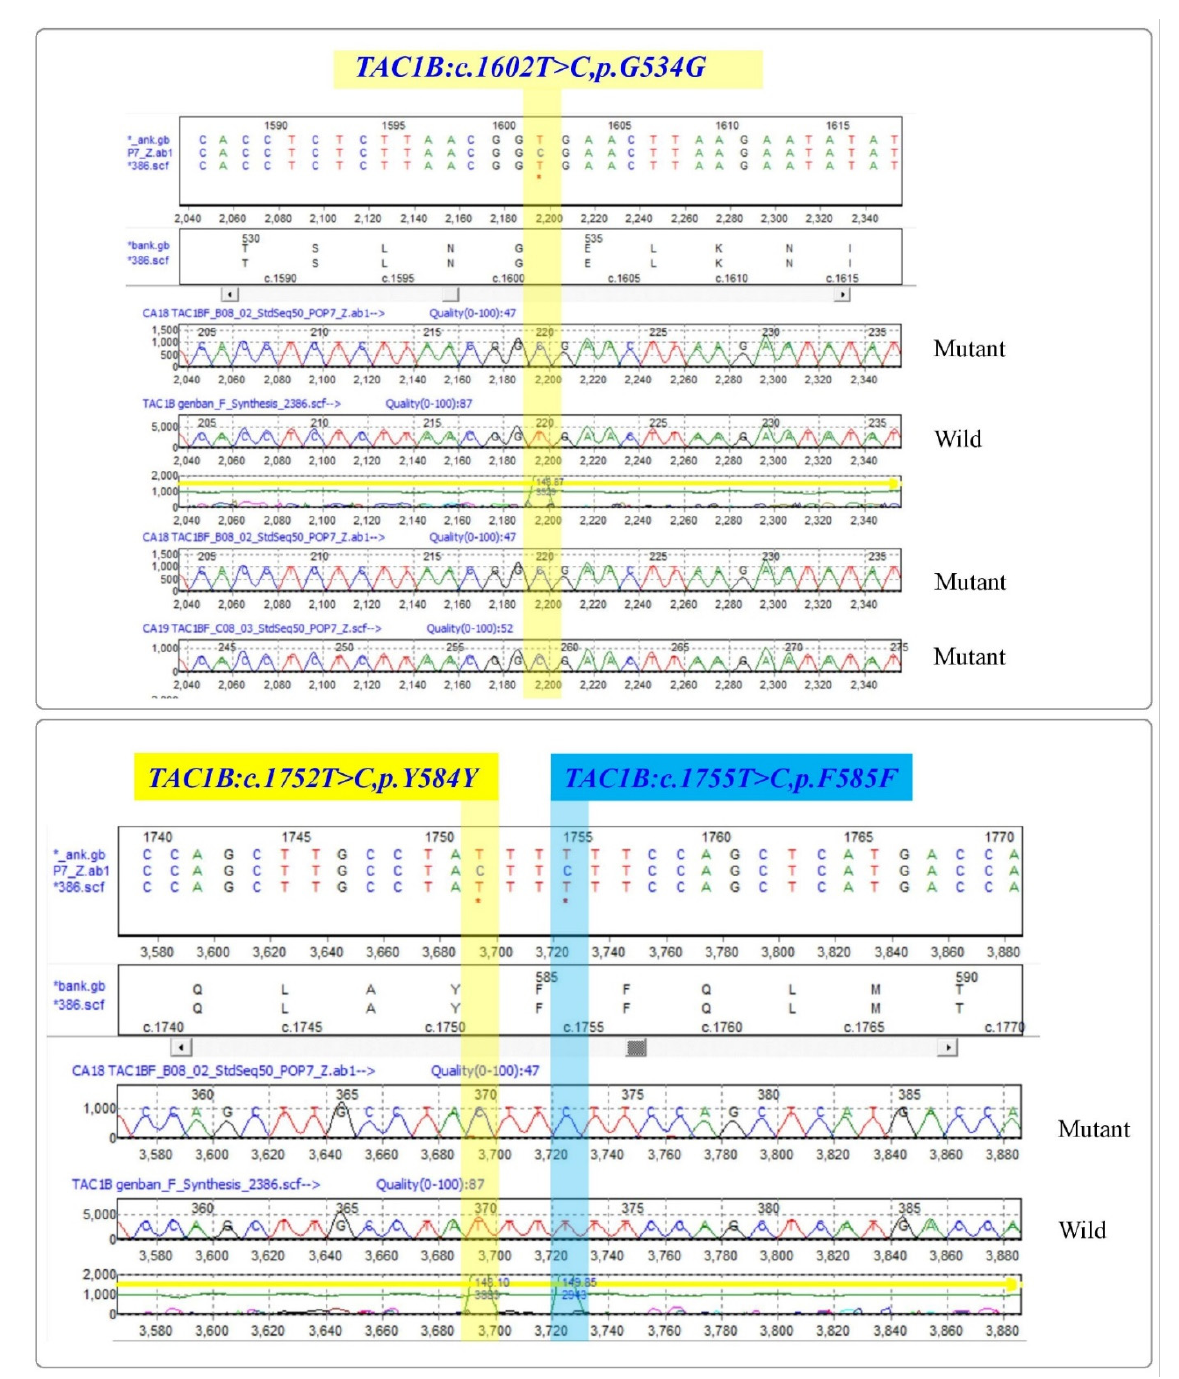
Figure 3. List of silent mutations identified in the zinc-cluster transcription factor-encoding gene ( TAC1B ) of Candida auris isolates. Top: TAC1B:c.1602T > C,p.G534G ; Bottom left: TAC1B:c.1752T > C,p.Y584Y ; Bottom right: TAC1B:c.1755T > C,p.F585F . Reference sequence: GenBank Accession: MW368409.1. * indicates change of nucleotide at this position.